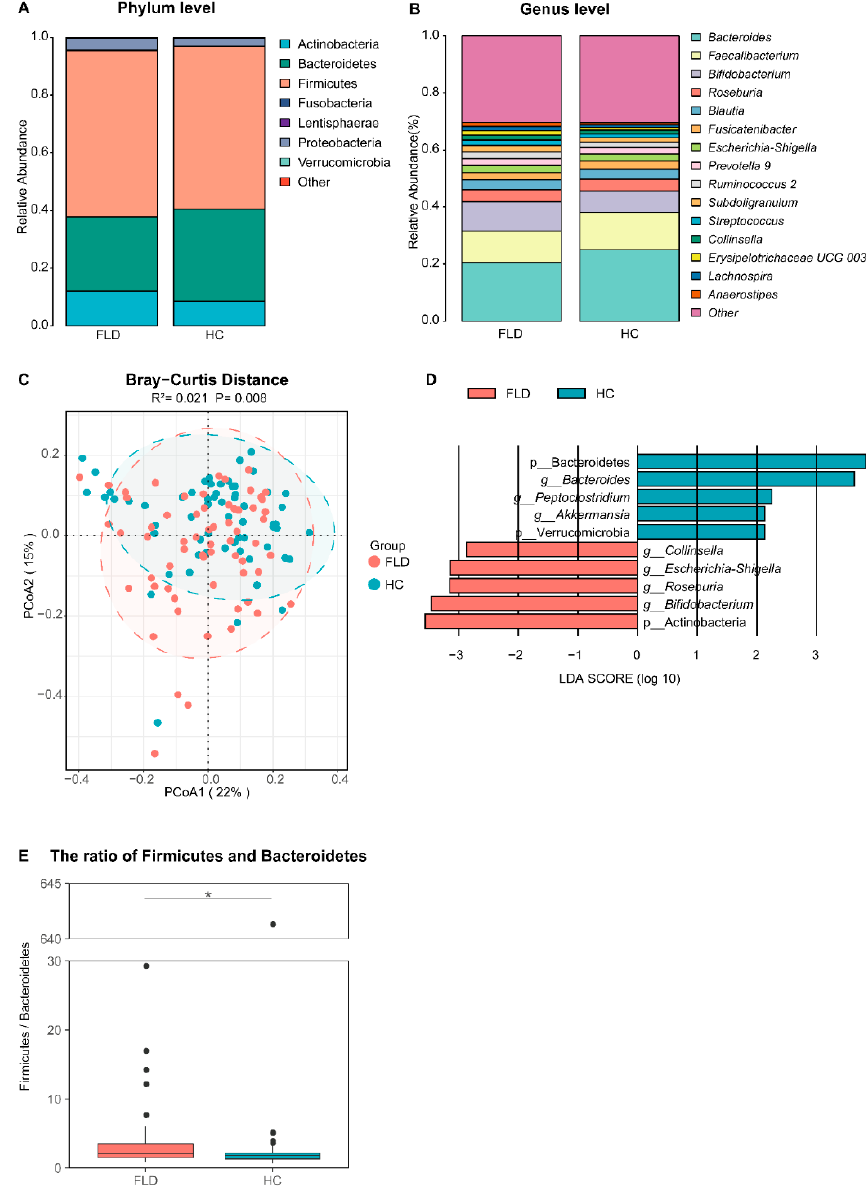
Figure 1. Relative abundance of gut microbiota at the phylum level ( A ) and the genus level ( B ). ( C ) The beta diversity of microbial communities between the children with NAFLD and healthy children was significantly different (R 2 = 0.021, p = 0.008). ( D ) The LEfSe results of the children with NAFLD and healthy children. High abundances of Actinobacteria, Collinsella , Escherichia-Shigella , Roseburia , and Bifidobacterium were found in the gut microbiota of children with NAFLD. The abundances of Bacteroidetes, Verrucomicrobia, Bacteroides , Peptoclostridium , and Akkermansia were higher in the gut microbiota of healthy children. ( E ) The ratio of Firmicutes and Bacteroidetes was significantly higher in gut microbiota in healthy children than in children with NAFLD, * p < 0.05.